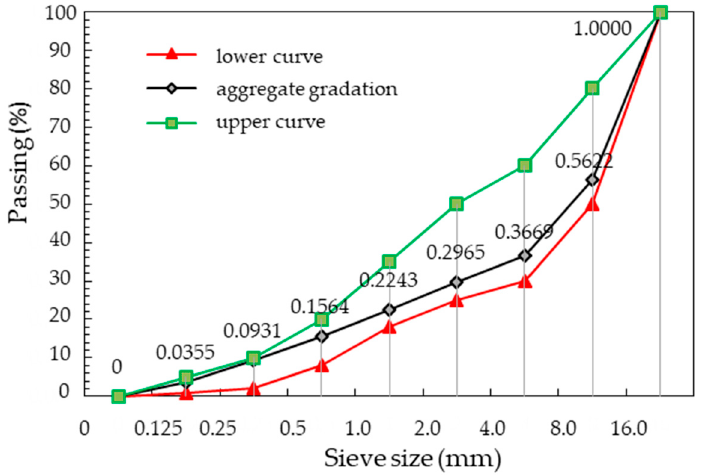
Figure 2. Gradation of quartz sand.